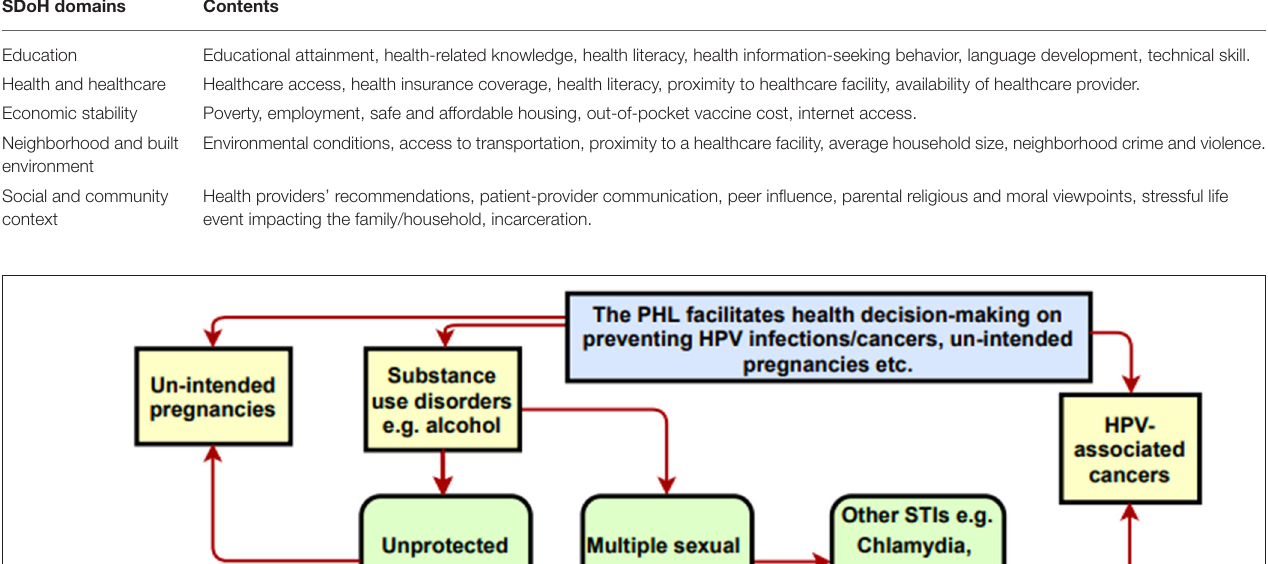
report a lack of knowledge and awareness of HPV, its transmissibility through skin-to-skin contact, the existence of HPV-associated cancers, and HPV vaccine efficacy and